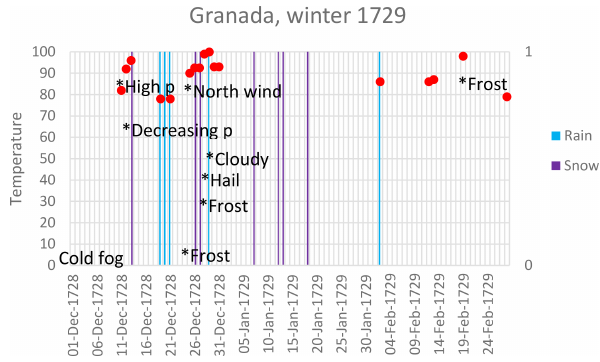
Figure 8. Observations during winter 1729. Left axis (dots): tem- perature according to Navarrete’s scale. Right axis: rainy and snowy